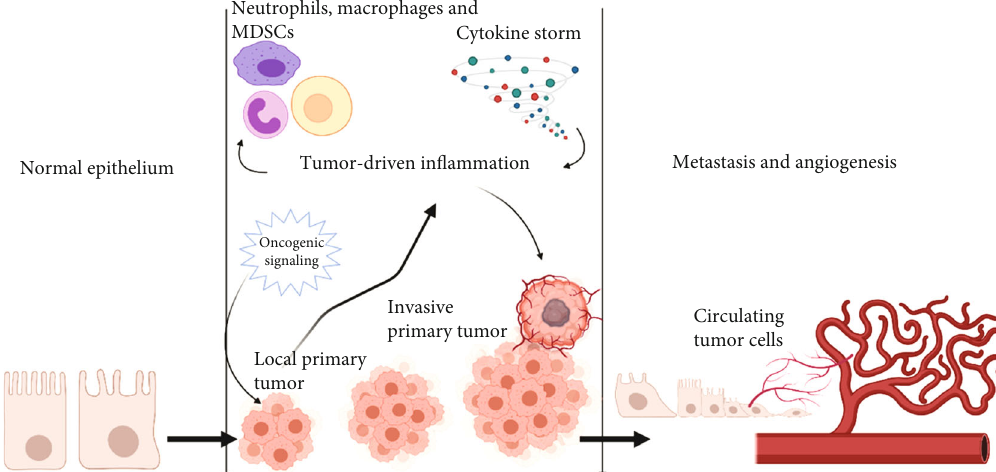
Figure 1: Crosstalk between in fl ammation and EMT in tumor progression. Proin fl ammatory cytokine molecules which are released by tumor cells drive epithelial-mesenchymal transition (EMT), invasion, and metastasis.